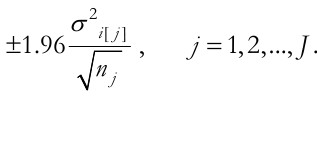
142 n (cid:32) residuals,